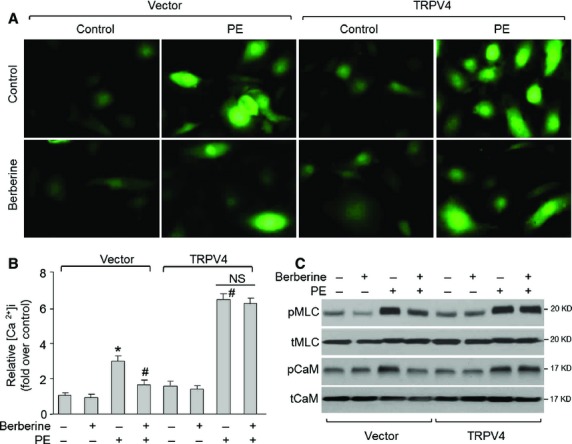
Berberine via suppression of transient receptor potential vanilloid 4 (TRPV4) induces relaxation of vascular smooth muscle cells. Cultured human VCMCs infected with adenovirus containing vector or TRPV4 cDNA for 48 hrs were incubated with berberine (10 μM) for 60 min. followed by stimulation with PE (1 μM) for 30 min. (A) Intracellular Ca2+ ([Ca2+]i) concentration was assayed by detecting Fluo-4-AM fluorescence. Relative [Ca2+]i concentration was calculated by the ratio of fluorescent intensity to control. The fluorescent intensity in control was set up as 1. The representative picture was presented from three independent experiments. (B) Summary data for [Ca2+]i concentration in A. Quantitative results are expressed as mean ± SEM, *P < 0.05 versus Vector, #P < 0.05 versus Vector plus PE. NS indicates no significant difference. (C) Total cell lysates were subjected to perform Western blot for detection of pCaM, tCaM, pMLC and tMLC protein levels. The MWs of pMLC (or tMLC) and pCaM (or tCaM) match the expected sizes. The blot is a representative blot obtained from three independent experiments.